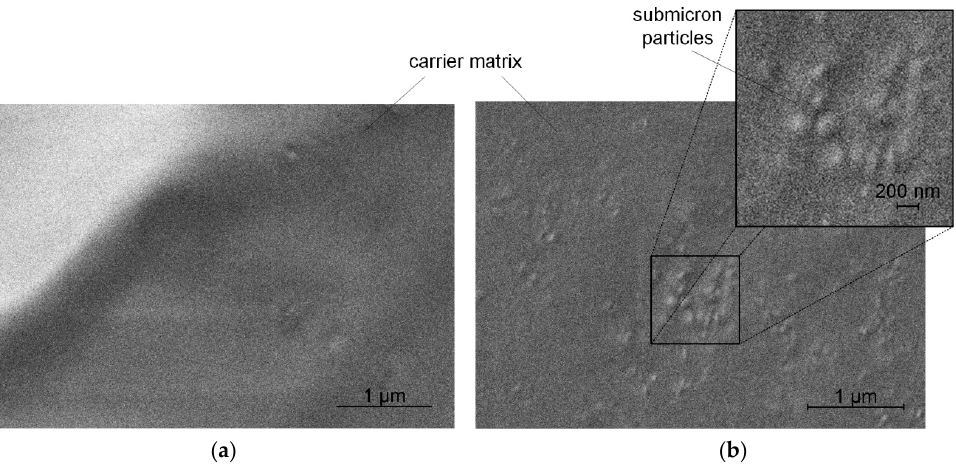
Figure 3. ( a ) Scanning electron microscope (SEM) image of the unloaded carrier surface; ( b ) and submicron naproxen particles in a xylitol carrier.